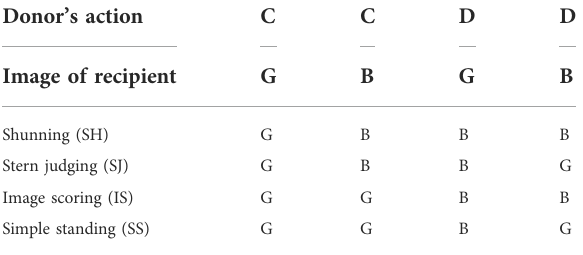
TABLE 1 Typical norms which have pro-social